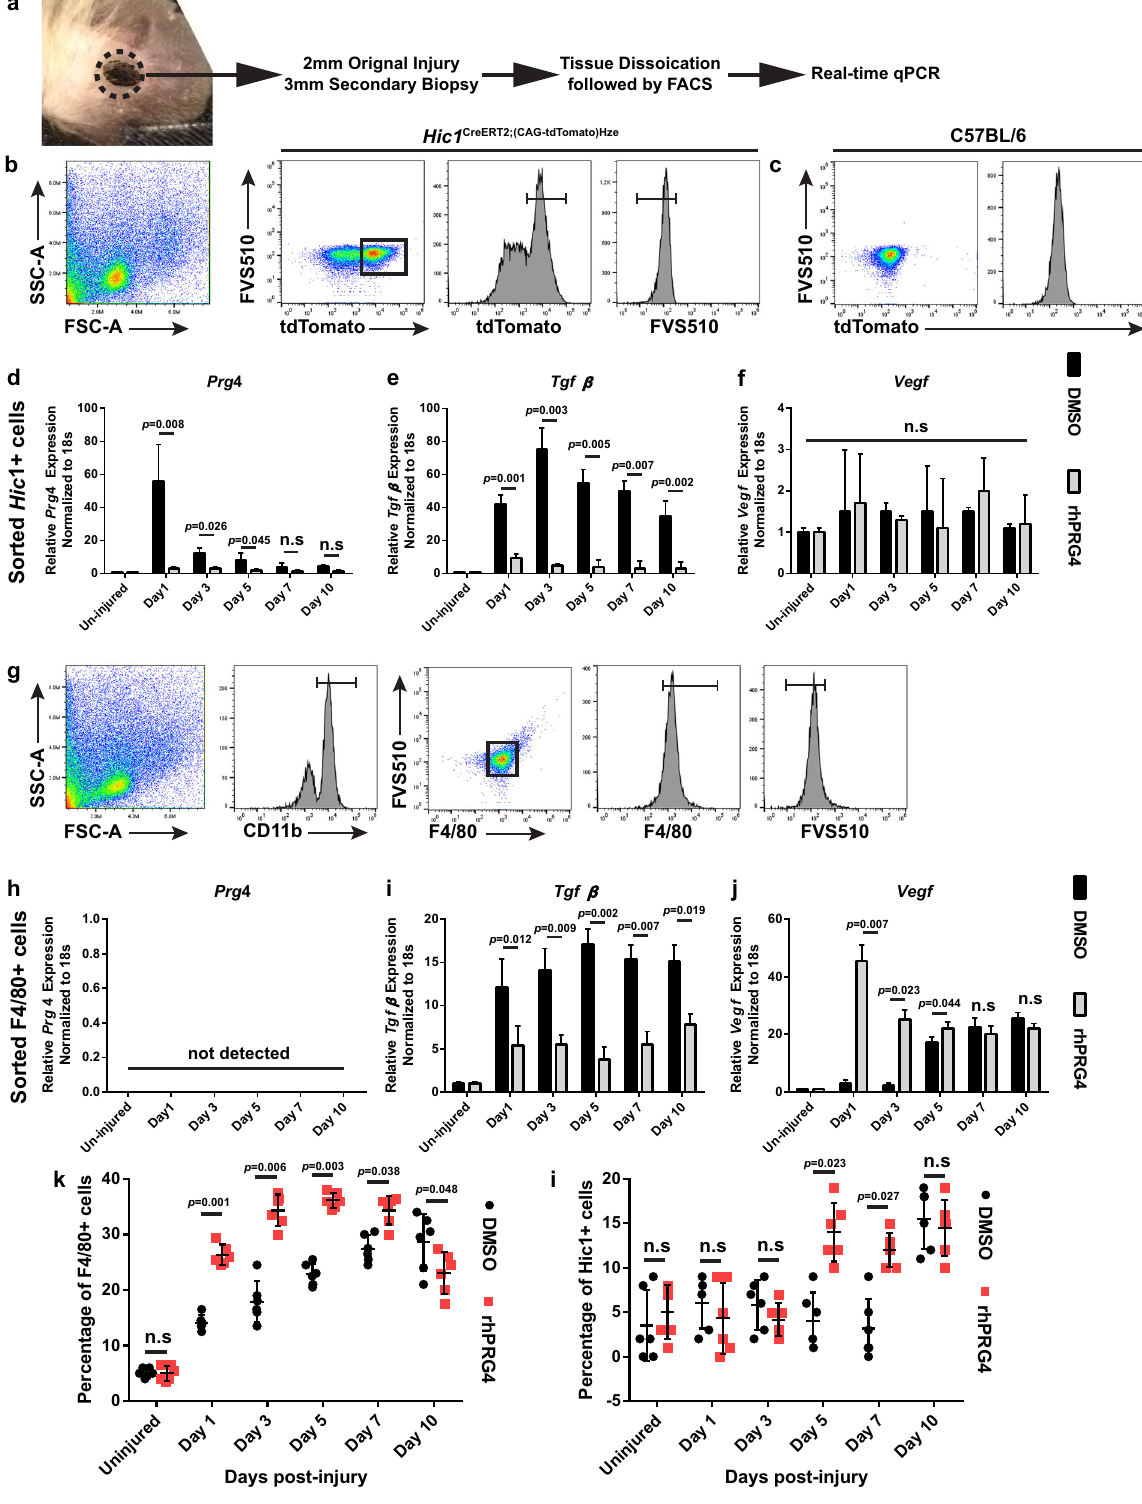
Fig. 7 Gene expression in isolated progenitors and macrophages with rhPRG4 treatment. A 3 mm secondary biopsy was generated around the primary 2 mm wound injury at various timepoints post-injury and the isolated cells were puri fi ed and examined by qPCR a . Live, tdTomato + b , c , Hic1 + progenitors were assayed for Prg4 , Tgf β and Vegf expression d – f . Both Prg4 and Tgf β levels were upregulated by rhPRG4, while no Vegf response was observed to rhPRG4. Live, CD11b + , F4/80 + macrophages g were assayed for Prg4 , Tgf β and Vegf expression h – j . Prg4 was not detected in macrophages, however both Tgf β and Vegf levels were upregulated by rhPRG4. The number of Hic1 + and F4/80 + cells were quanti fi ed post-injury and it was observed that F4/80 + macrophage numbers increased immediately after rhPRG4 treatment k ; while Hic1 + cells increased at day 5 post-rhPRG4 treatment/injury l . All experiments were undertaken on at least 3 biological and 3 technical replicates unless otherwise stated. n.s. = not signi fi cant. Error bars equal mean ± SD ( d , e , f , h , I , j , k , l –